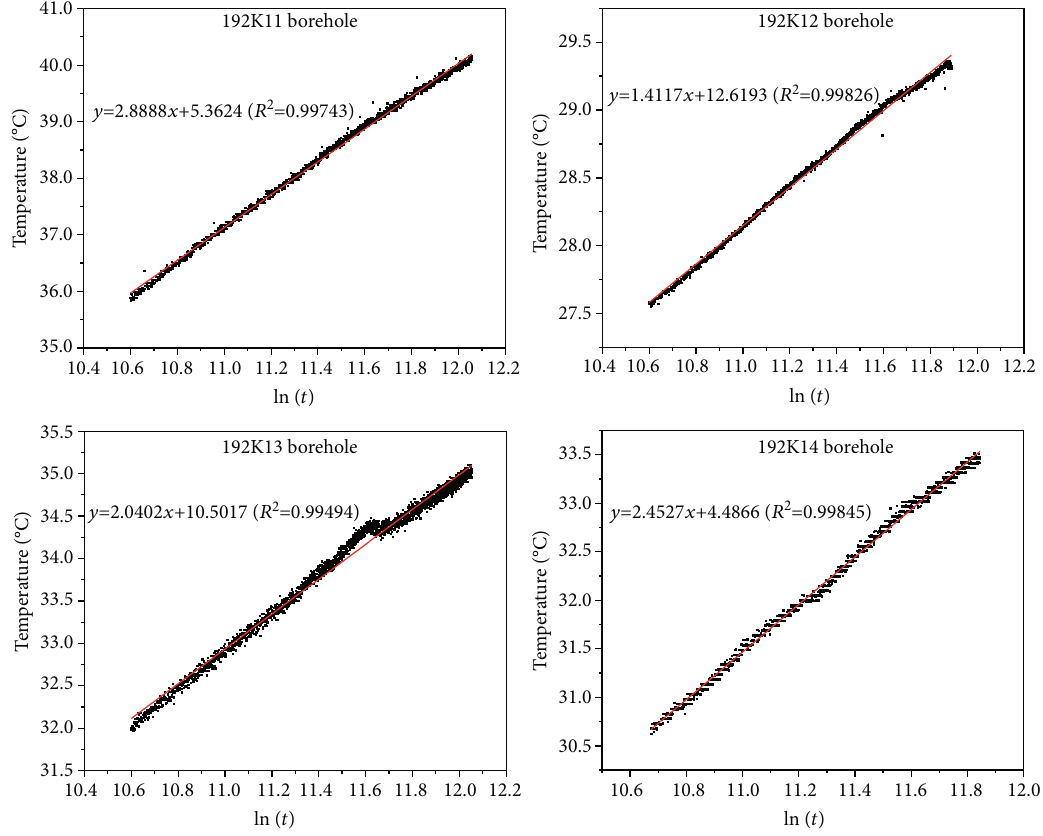
ln ð t Þ in four geothermal test holes. f with